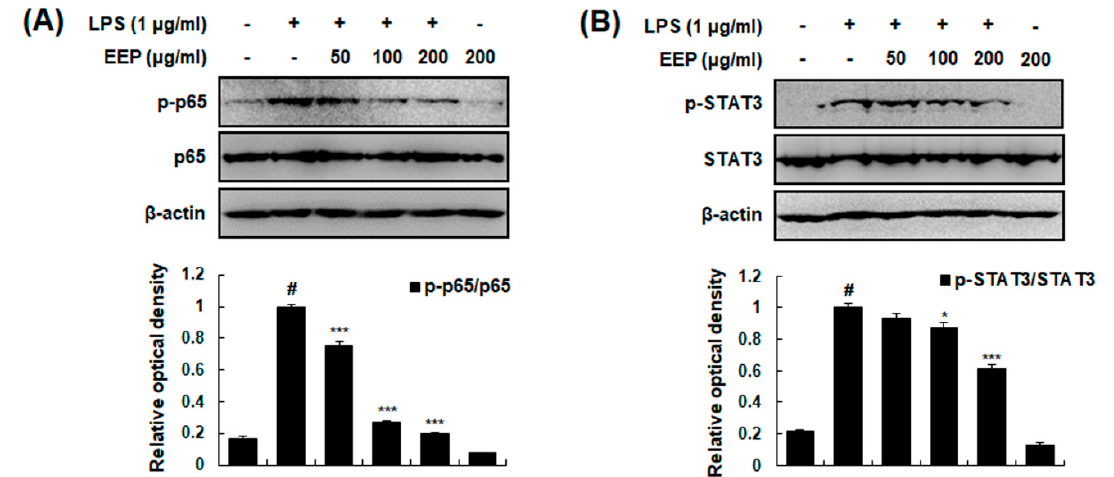
Figure 8. Effects of EEP on activation of NF- κ B and STAT3 in RAW 264.7 macrophages. ( A , B ) Total cellular proteins were obtained from cells stimulated with LPS (1 µ g/mL) for 15 min (p-p65) or 2 h (p-STAT3) with or without indicated dose of EEP and analyzed by Western blotting. Levels of p-p65, p65, p-STAT3, and STAT3 were determined using specific antibodies. β -Actin was used as an internal control. Experiments were repeated three times and similar results were obtained. Values shown are means ± SDs of three independent experiments. # p < 0.05 vs. control group; * p < 0.05, *** p < 0.001 vs. LPS-stimulated